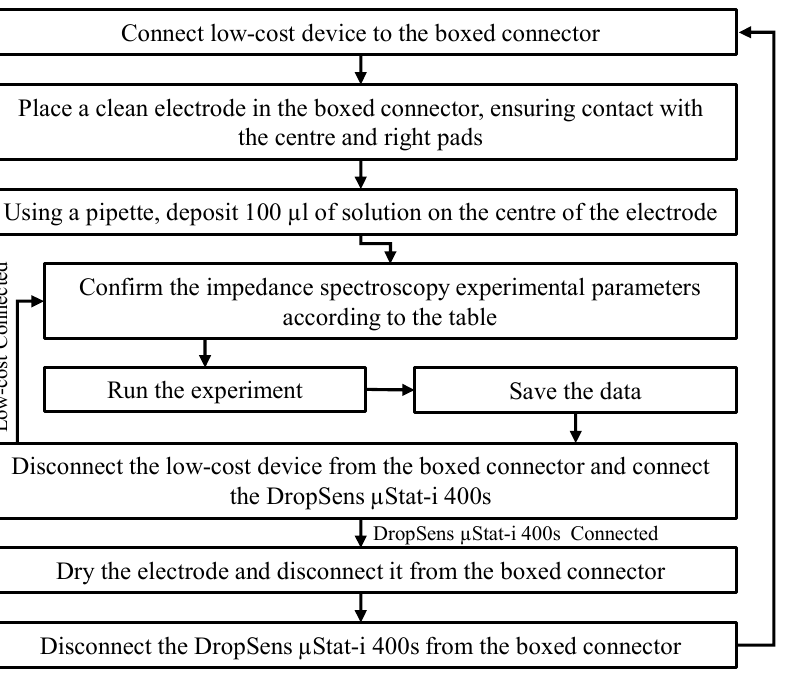
Figure 5. Flow diagram of experimental procedure for impedance